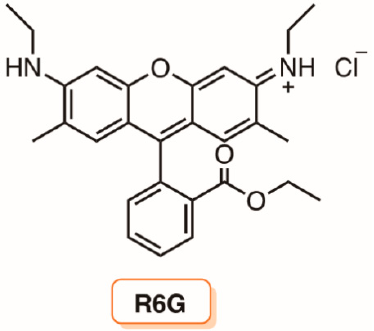
Figure 33. Structure of Rhodamine 6G that was encapsulated in liposomes (adapted from Reference